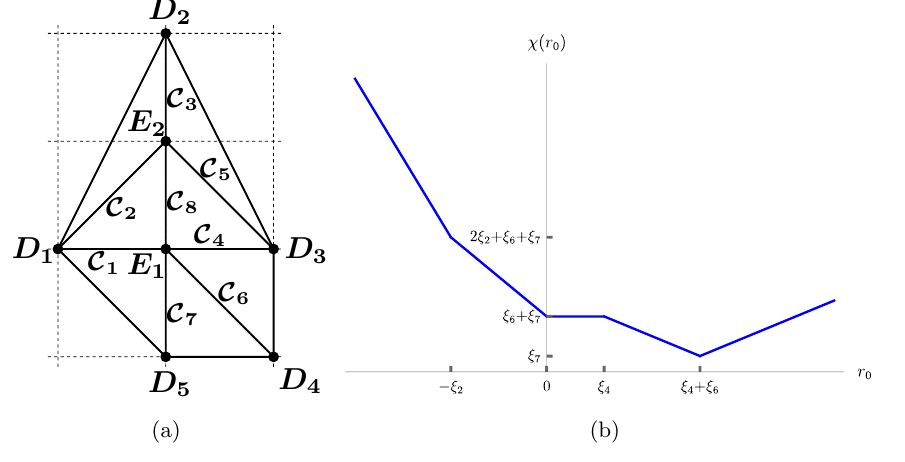
N f = 1 gauge theory. 2